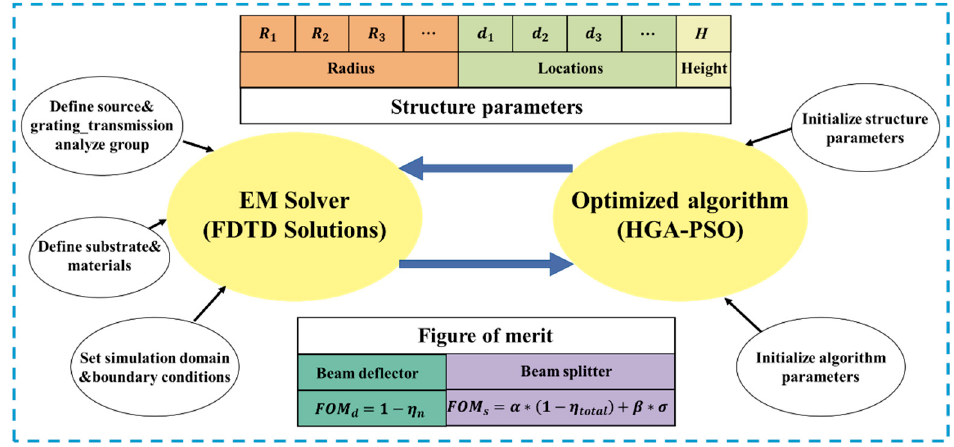
Figure 2. The framework for the optimization ‐ based inverse design methodology.